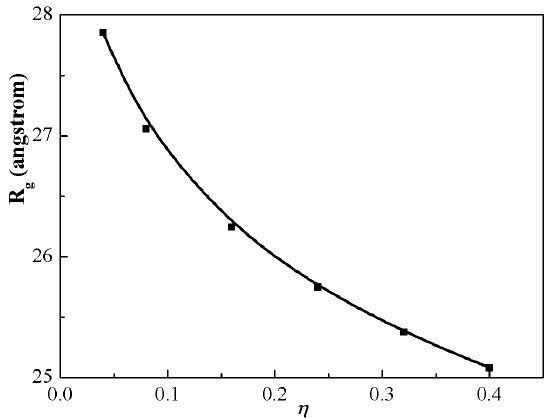
Figure 7. Gyration radius of PS chain as a function of packing fraction at 500 K. The chain length is fixed at 100 m